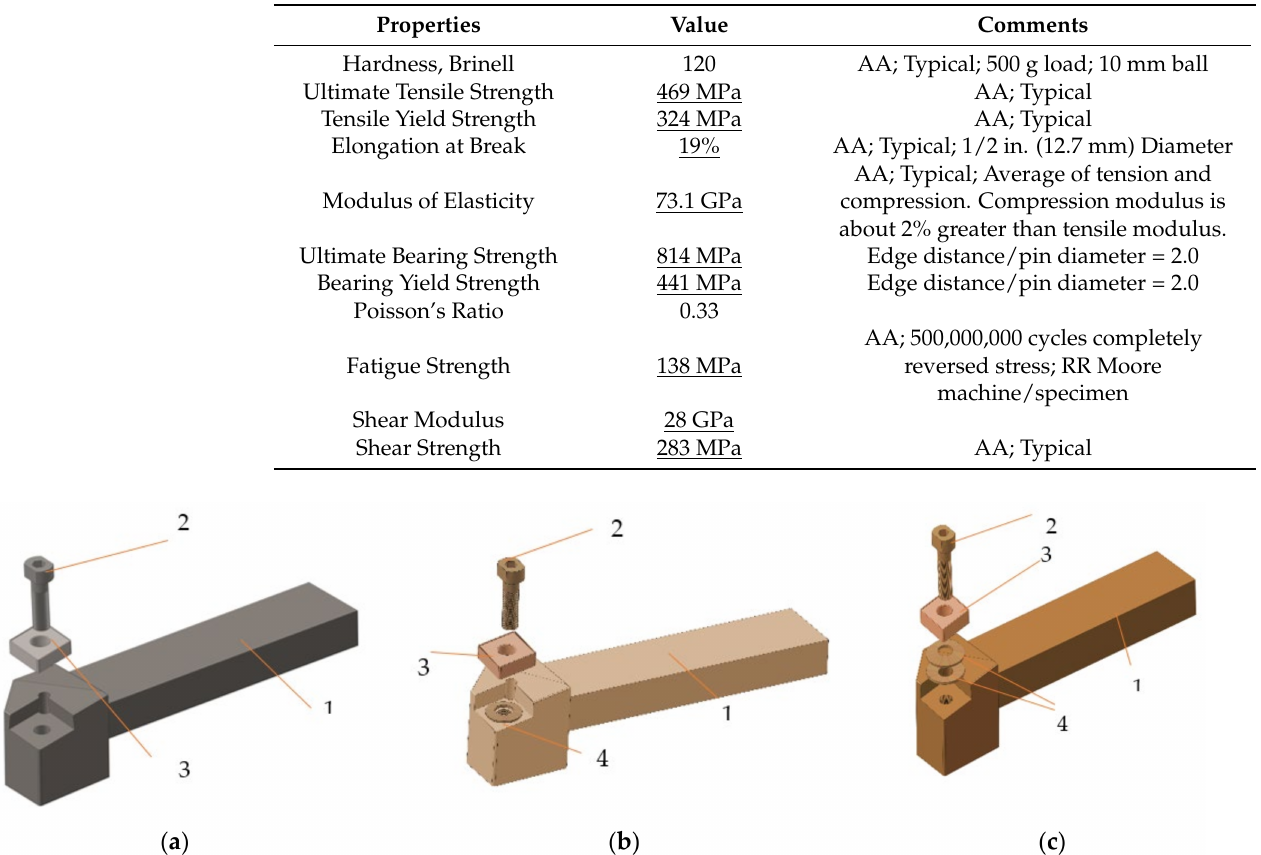
Table 2. Mechanical properties of aluminum alloy A2024-T351.